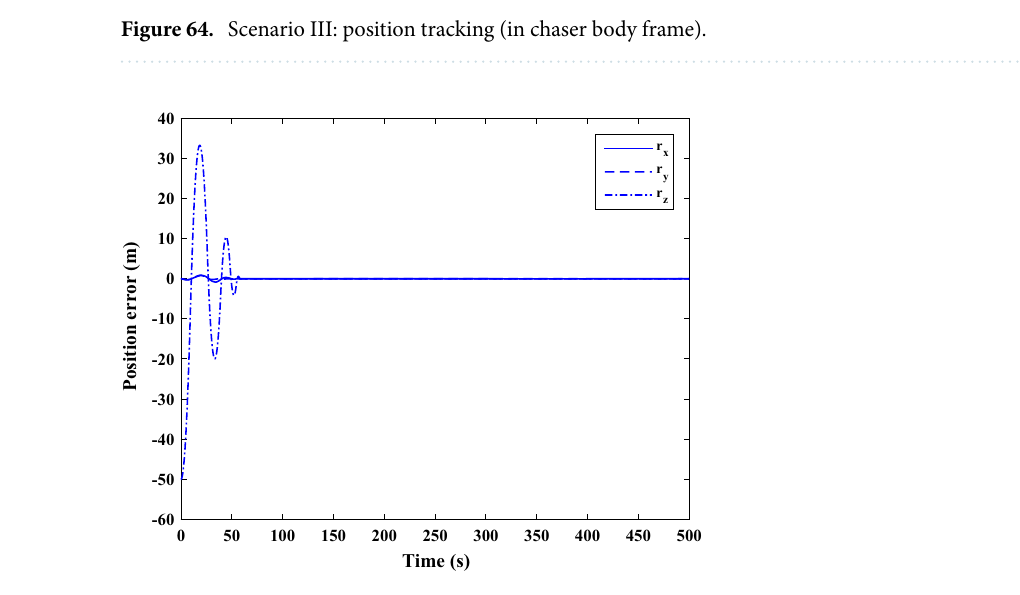
Figure 65. Scenario III: relative position error (in chaser body frame).